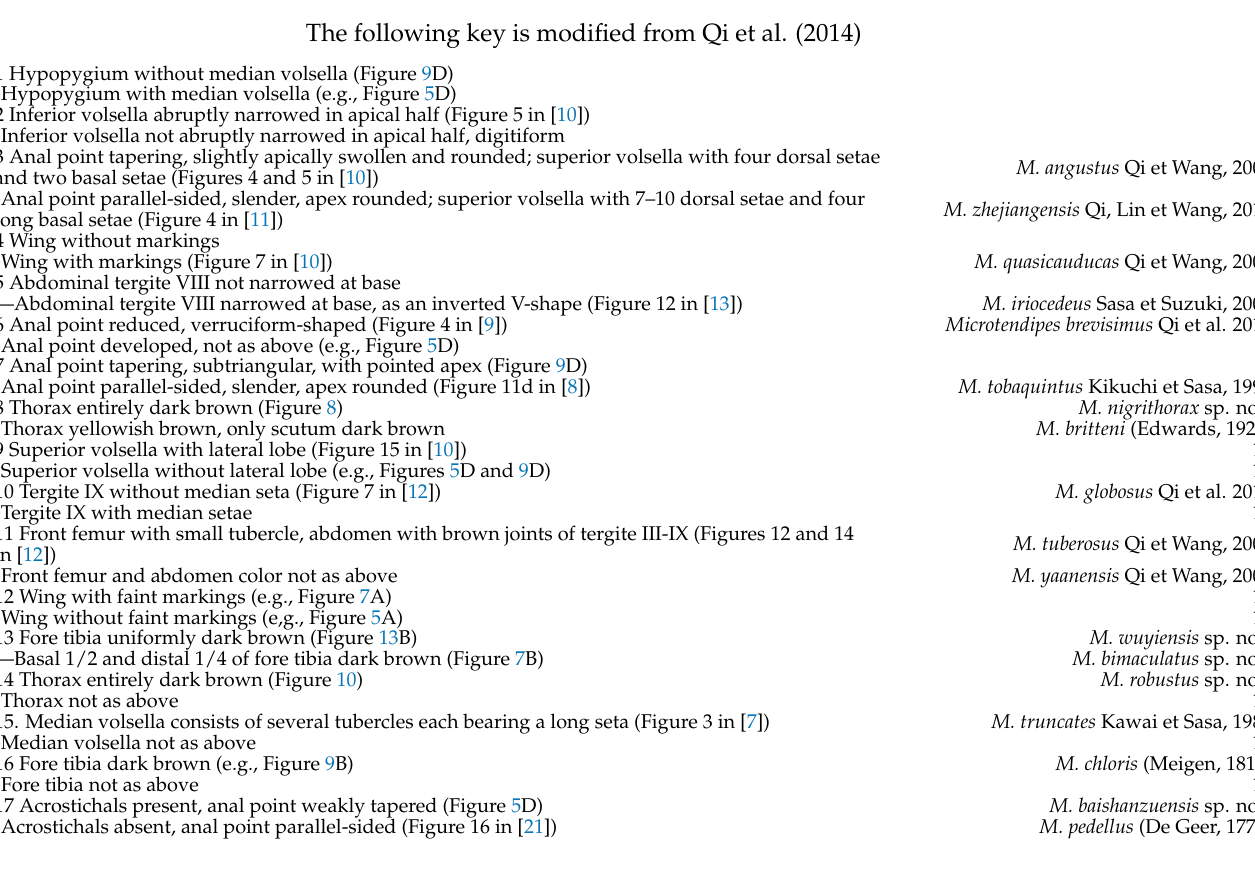
Figure S5: Maximum likelihood tree based on the PTP model; Table S1: Average intraspecific diver- gence among Microtendipes species. Table S2: Genetic divergence between Microtendipes sequences. Table S3: Average interspecific divergence between Microtendipes